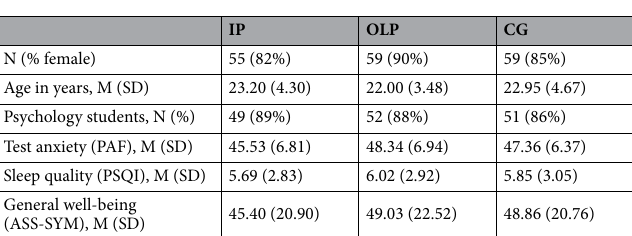
Table 1. Demographics and baseline scores of primary and secondary outcomes per group. ASS-SYM Änderungssensitive Symptomliste (general well-being), CG control group, IP imaginary pill, M mean,